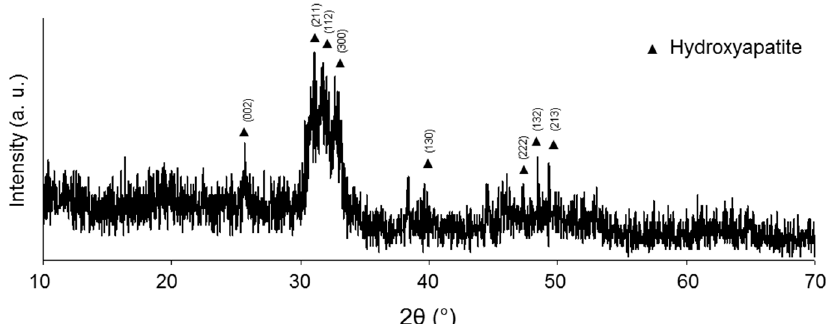
Figure 5. XRD pattern of TT-CEL2 after soaking for seven days in SBF.